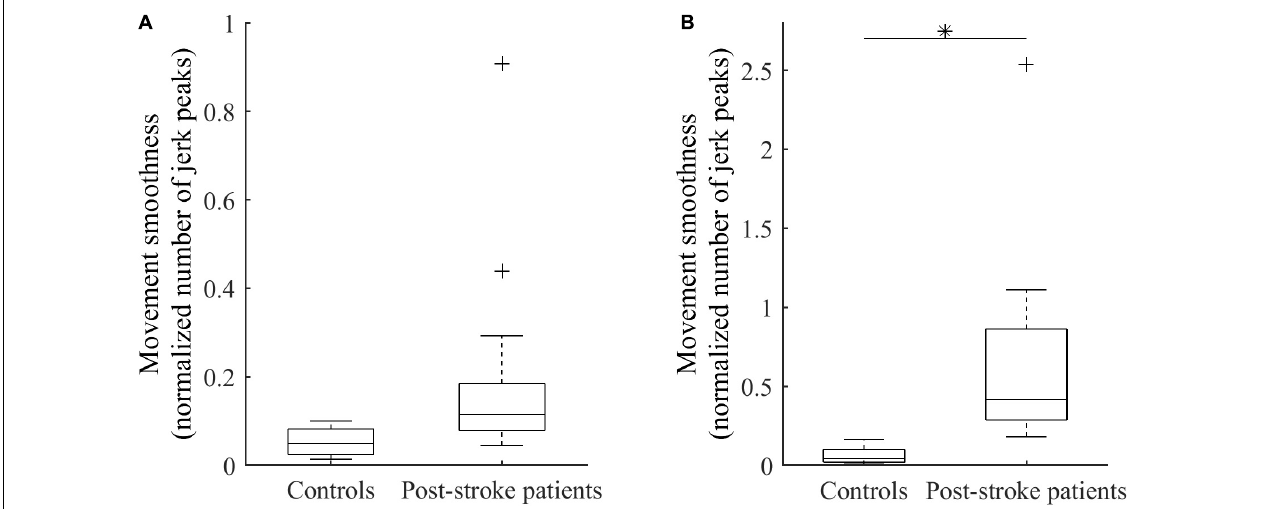
FIGURE 2 | Smoothness of elbow extension for controls and patients during the acceleration phase (A) and the deceleration phase (B) . ∗ Indicates a significant between-group difference ( p < 0.05).